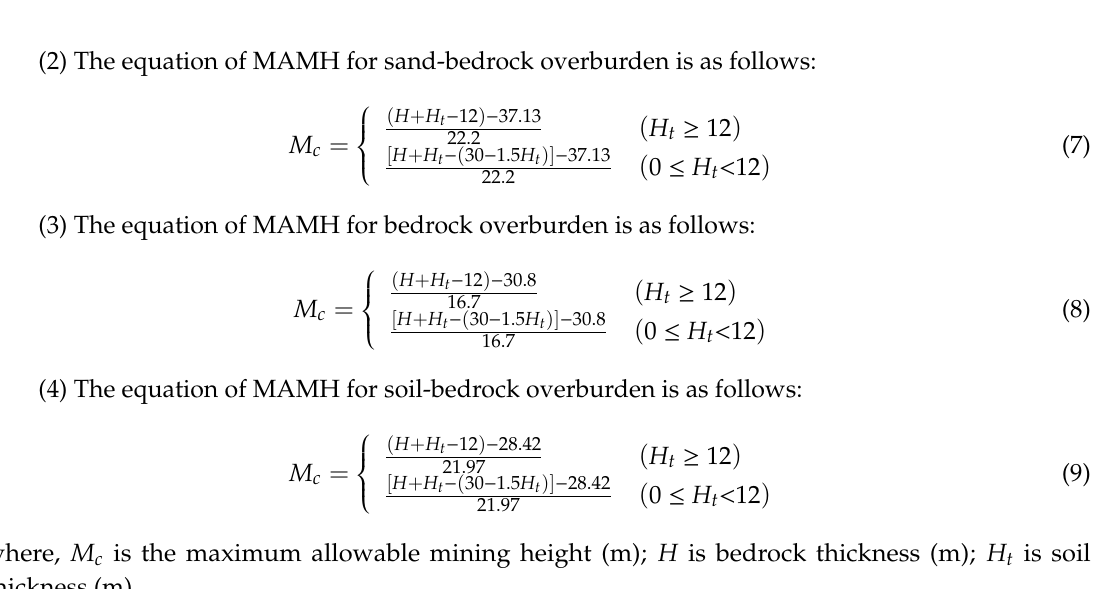
mining area is shown Figure 17.